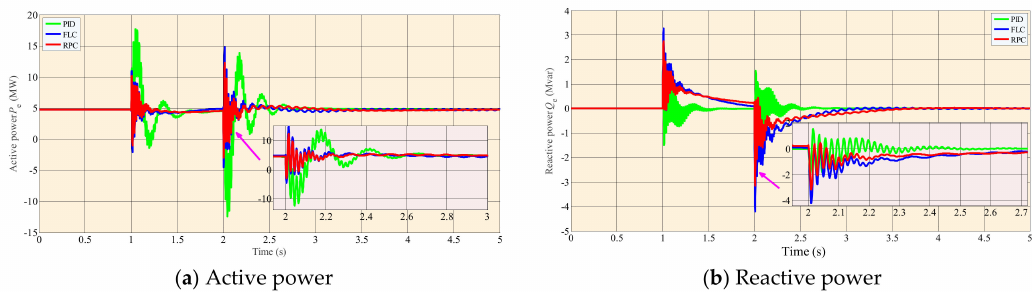
Figure 6. System responses obtained under a 40% voltage drop lasting 1 s at power grid with a constant wind speed of 10 m/s and fixed pitch angle of 5 deg. (operation type II). ( a ) active power; ( b ) reactive power